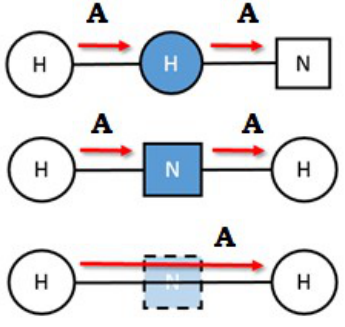
Fig. 16. Actors as intermediaries in chains of associations, transporting any given influence “A”. Up: human as intermediary; Middle: non-human as intermediary; Bottom: intermediaries’ social role is seldom noticed.